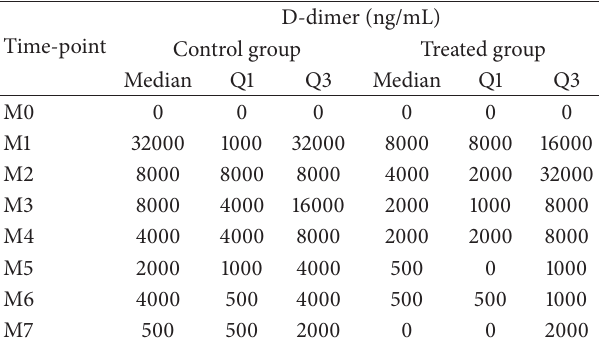
Table 3: Comparison of the peritoneal D-dimer concentrations between the CG and TG at different